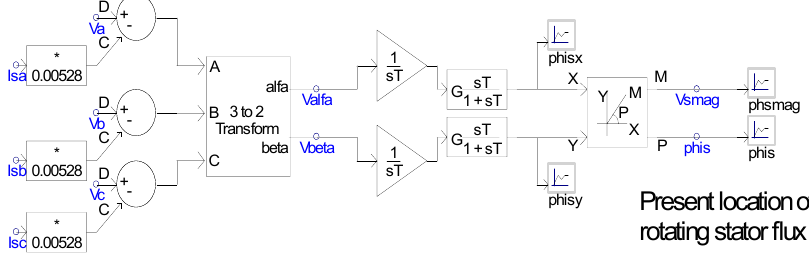
Figure A1. Finding the instantaneous position of the resultant stator flux of DFIG.